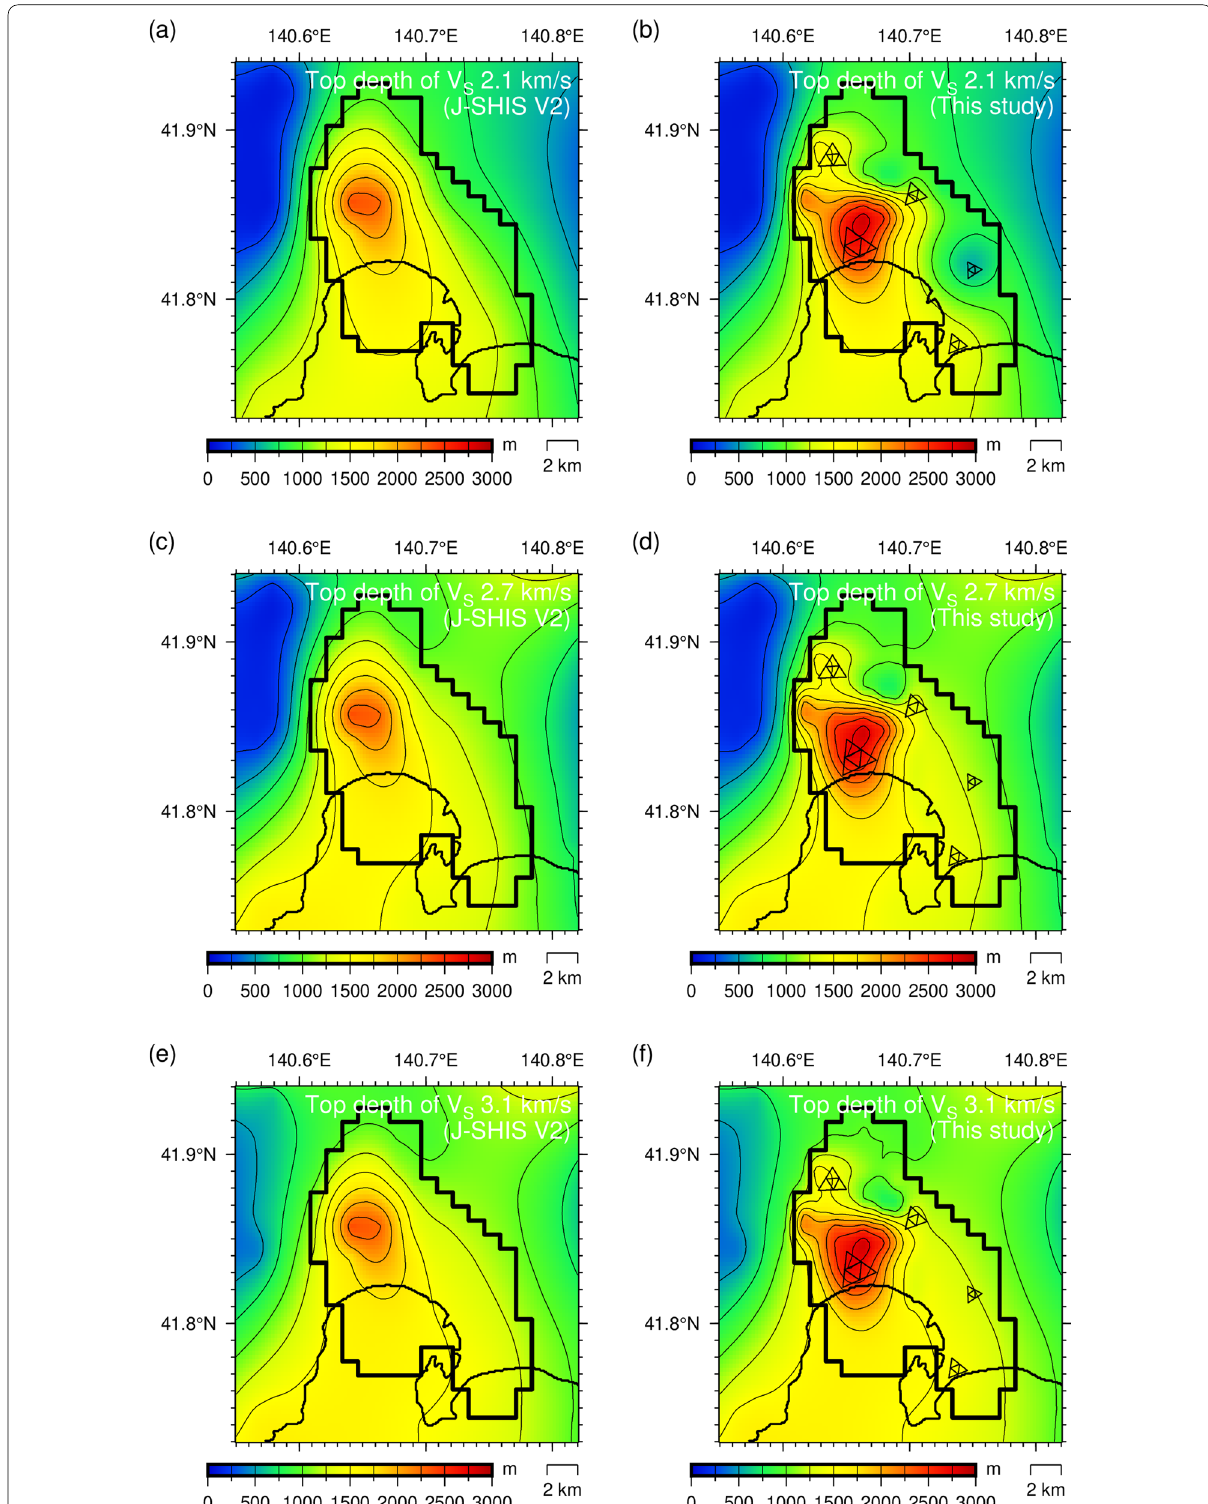
Fig. 7 Depth distributions of the top surface of each velocity layer. a V S of J-SHIS V2 model, d V S 2.7 km/s of this study, e V S = target area of the velocity structure modeling. The triangles indicate the microtremor array survey